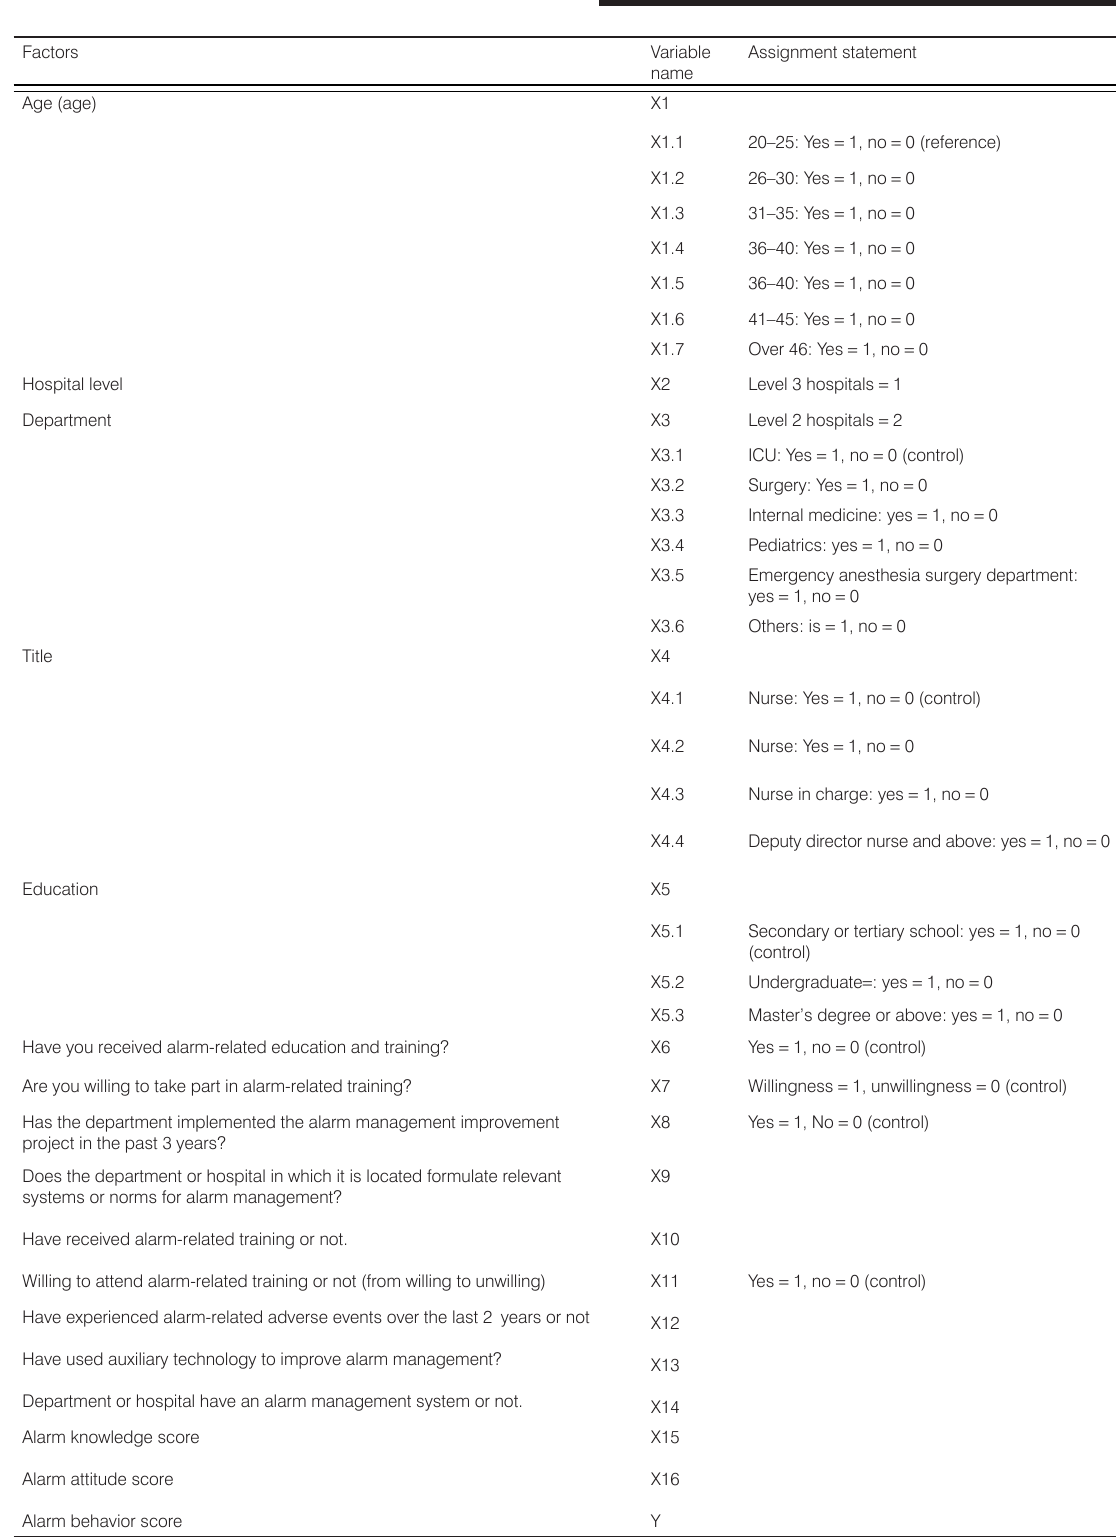
Table 4. Factors that influence nurses’ clinical alarm